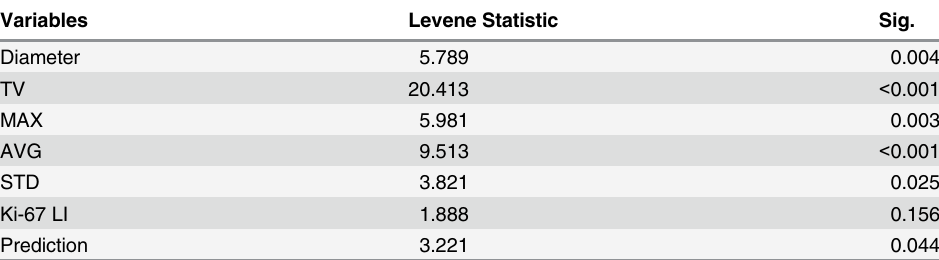
Table 2. Levene test of variables for homogeneity of